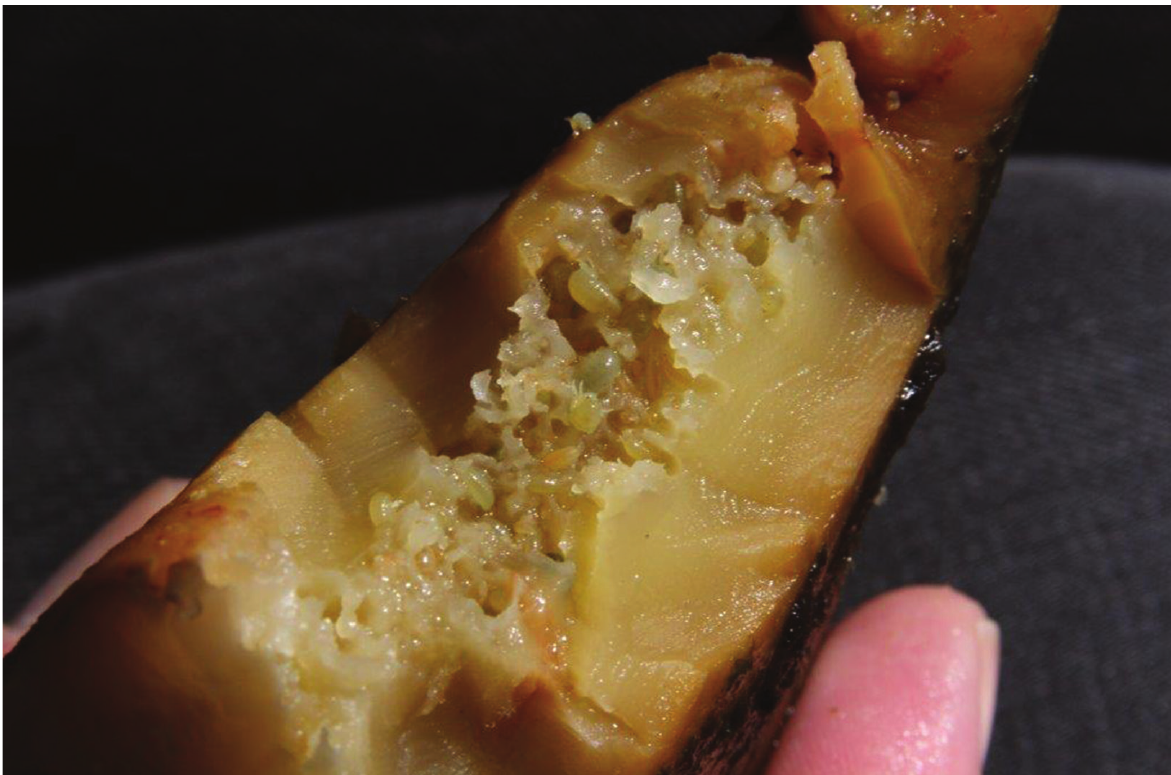
Figure 9. Bircenna species in their habitat, the bull kelp Durvillaea potatorum (Labillardière) Areschoug, 1854 collected in Tas- mania,